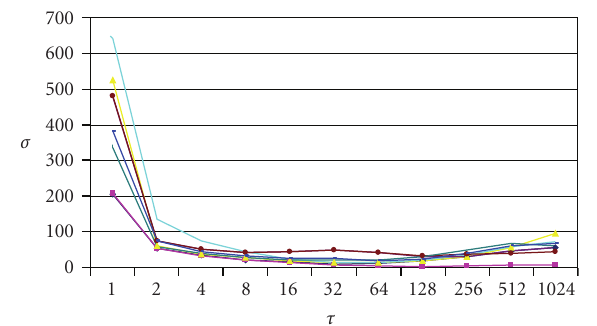
Figure 1: Allan deviation for 8 AMD processors.